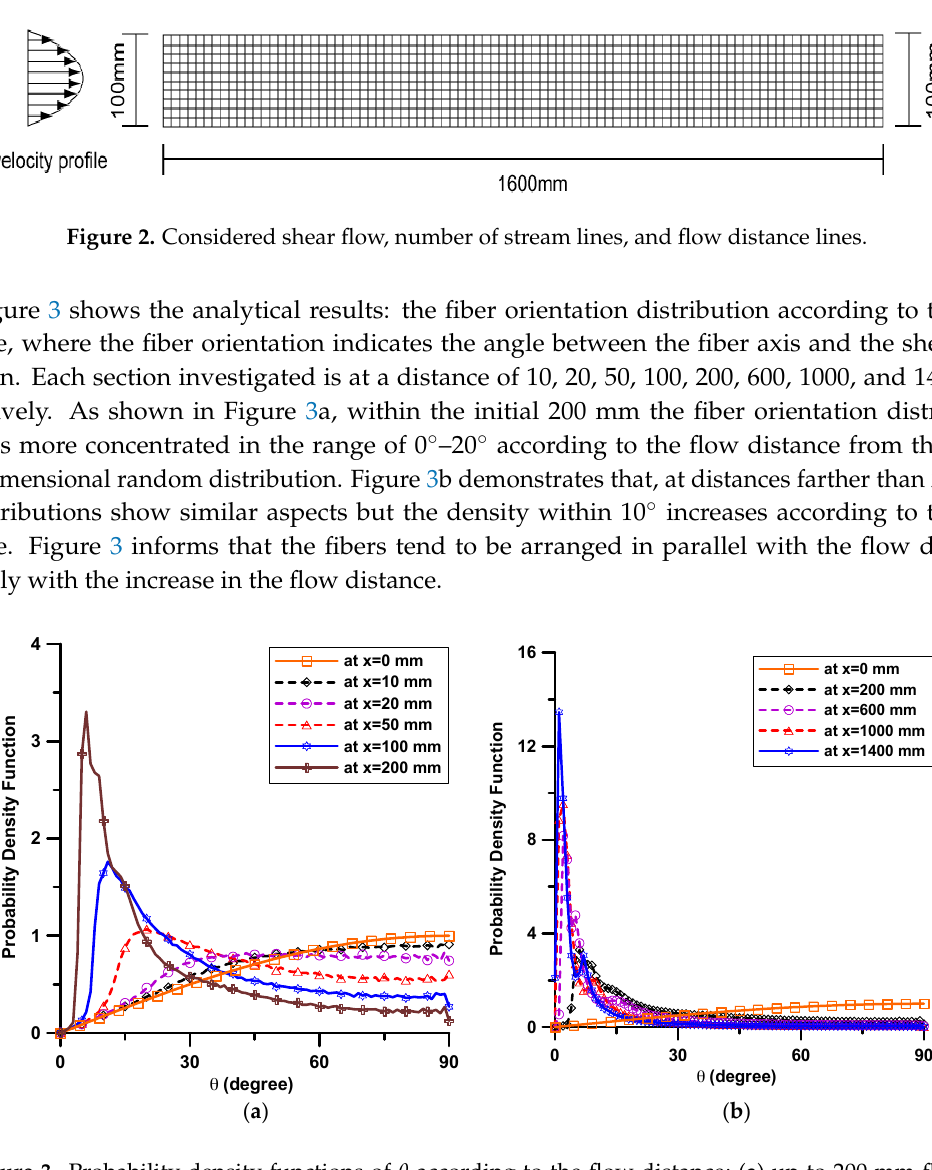
( b ) Figure 4. Simulated fiber bridging curves according to the flow distance; ( a ) up to 200 mm flow distance; and ( b ) for overall flow distance.